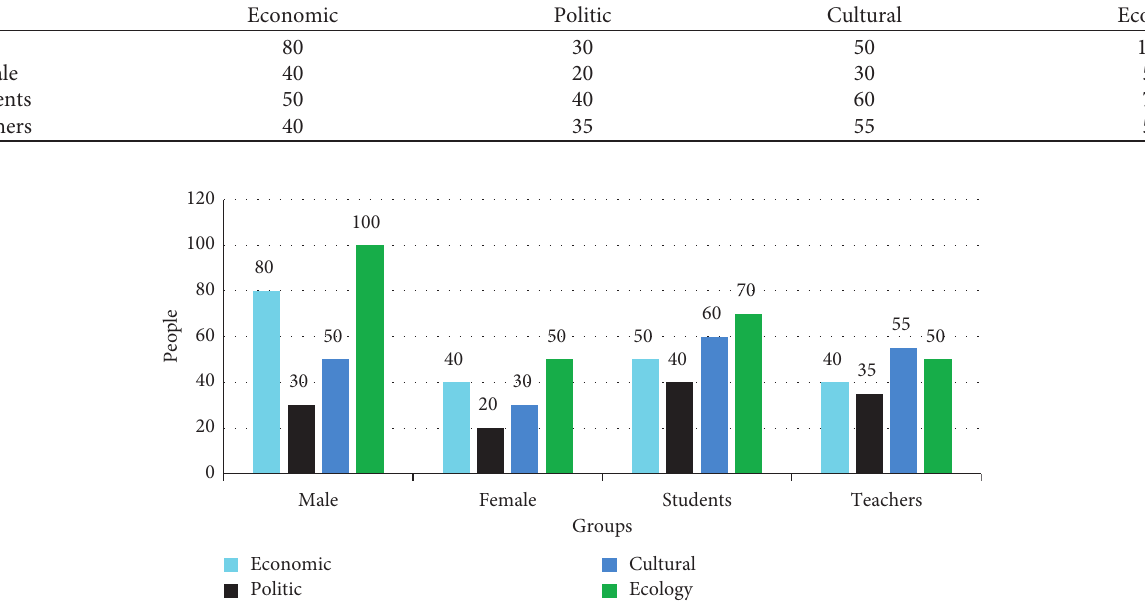
Figure 4: Respondents’ supportive attitudes towards global information. Table 3: Key issues of information recognition method.